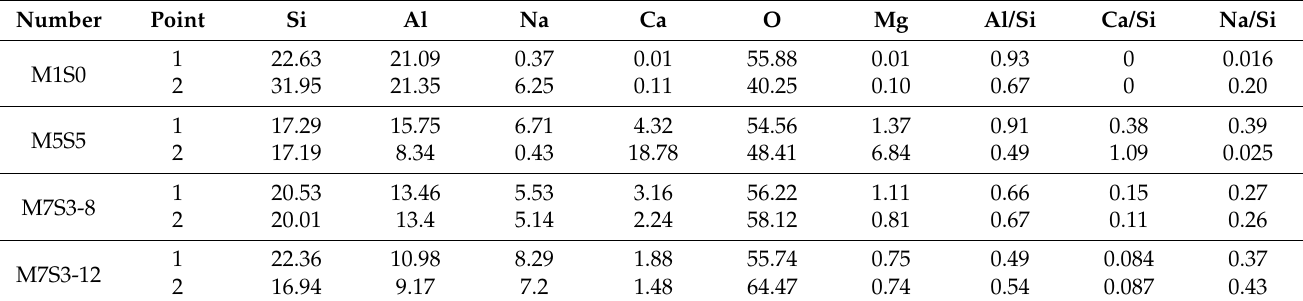
Table 3. Atomic percentages for the elemental composition at each spot in Figure 9